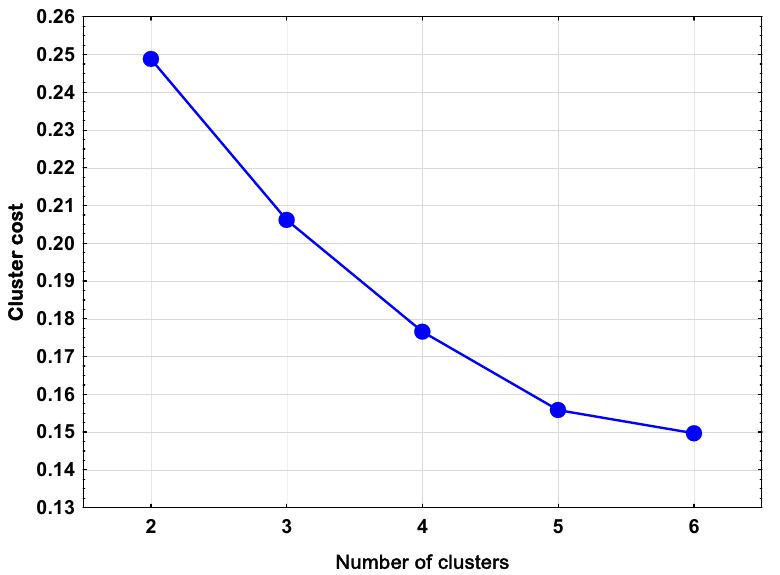
Figure 1. Cluster costs of different numbers of clusters resulting from k-means clustering combined with v -fold cross-validation. Table 2. Results of the multiple correspondence analysis (MCA) and k-means algorithm with v -fold cross-validation.